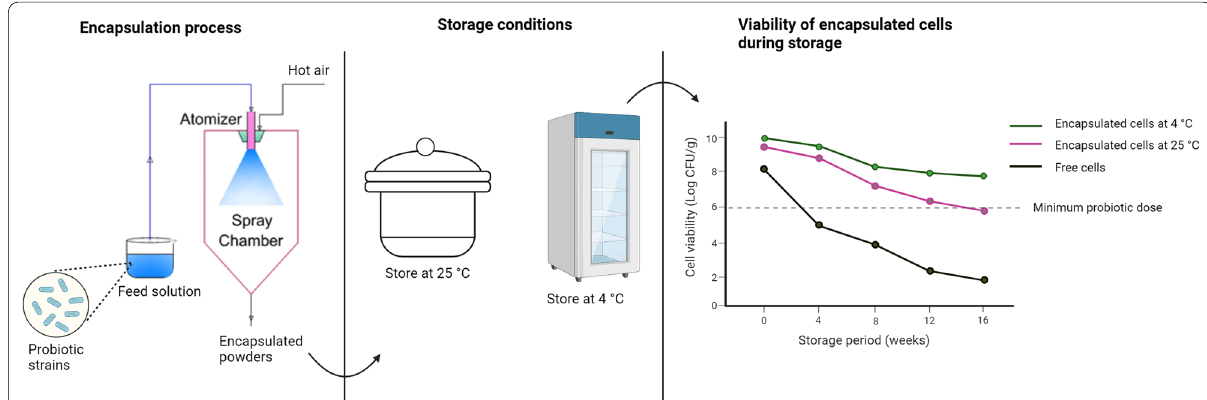
Fig. 5 Viability of encapsulated probiotics during storage [created with